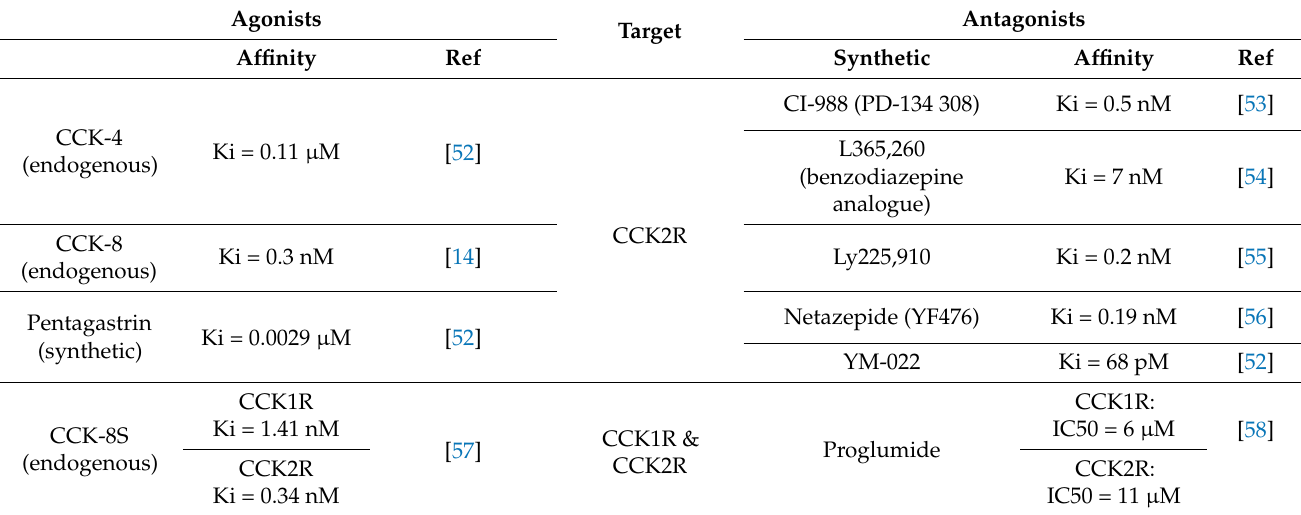
Table 1. Main CCK2R Agonists and